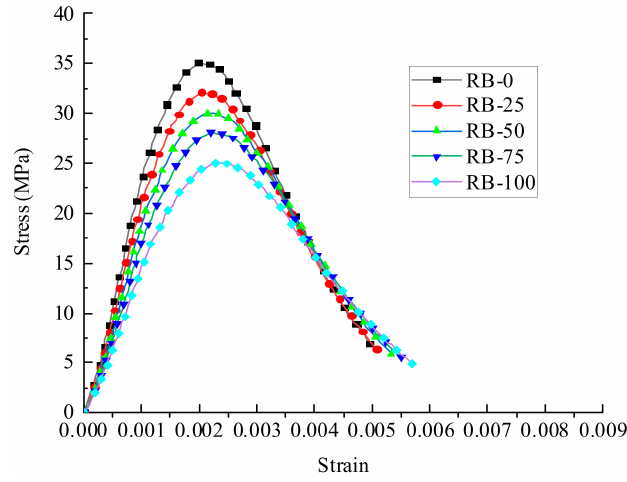
Figure 9. RBCA concrete stress–strain curve.